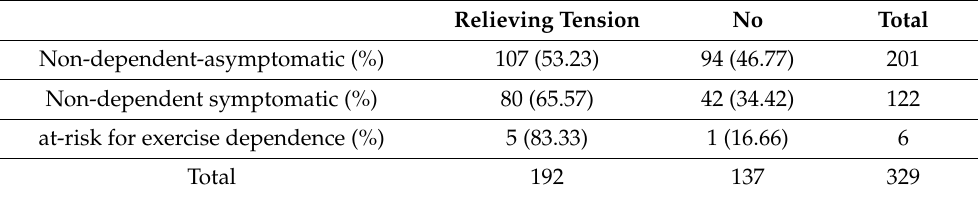
Table 5. Summary of cases EDS/Relieving tension.